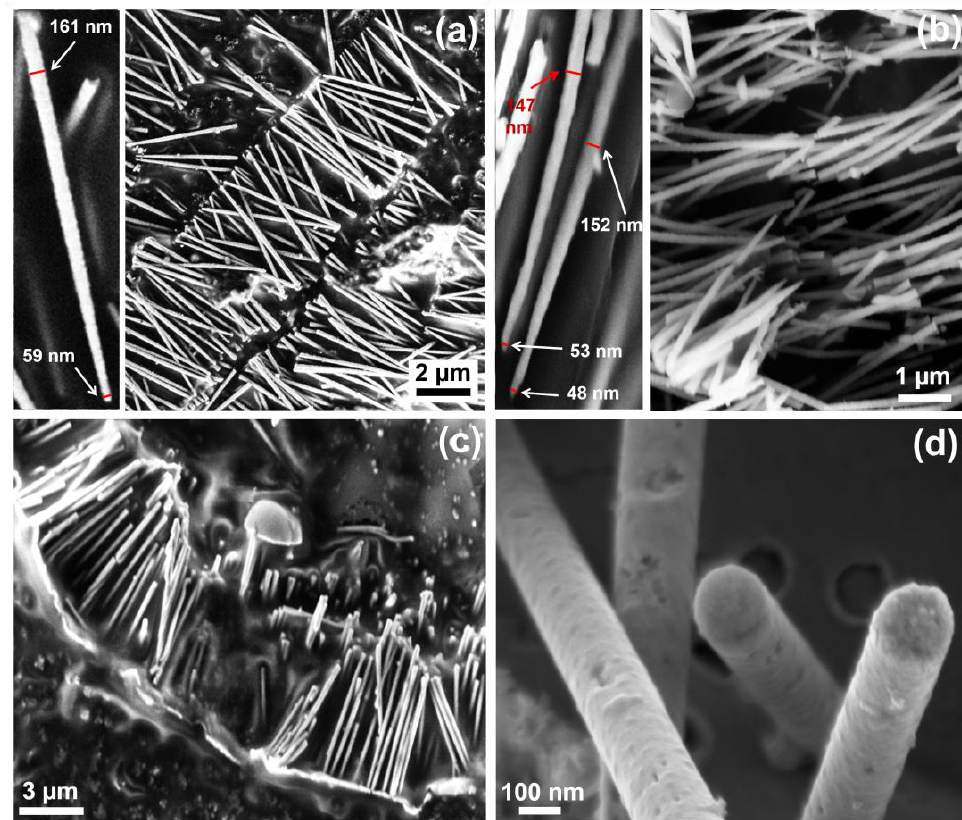
Figure 2. FESEM images of FePd NWs obtained by electrodeposition on PC membrane at E on of ( a ) – 1.05 V, ( b ) – 1.15 V, ( c ) – 1.2 V, and ( d ) – 1.3 V.